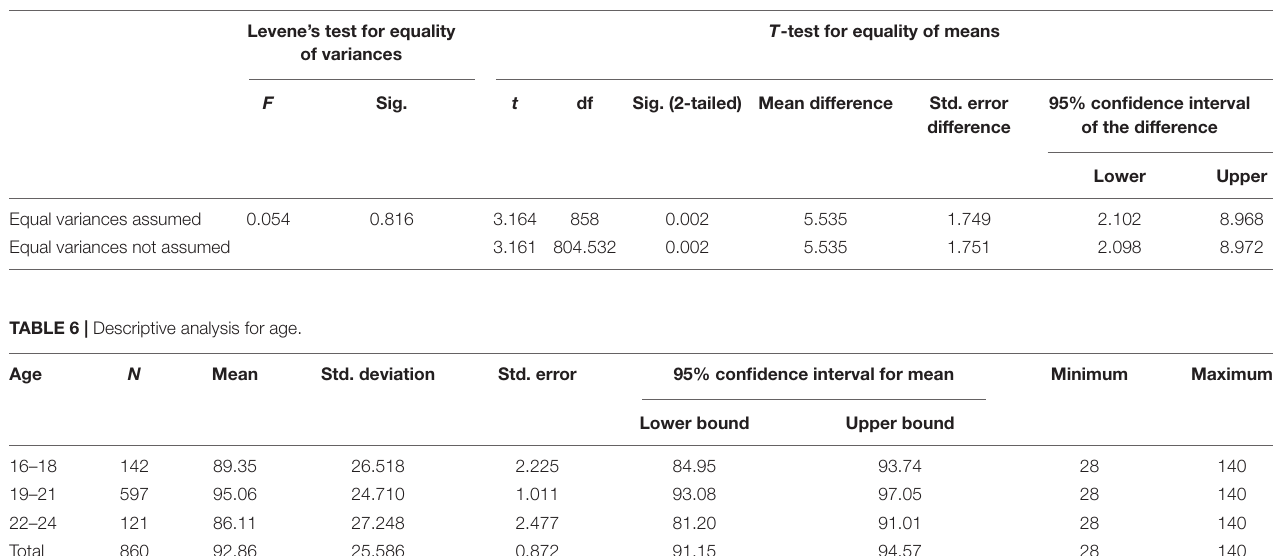
TABLE 5 | The results of willingness to communicate (WTC) differences in terms of major. Levene’s test for equality of variances